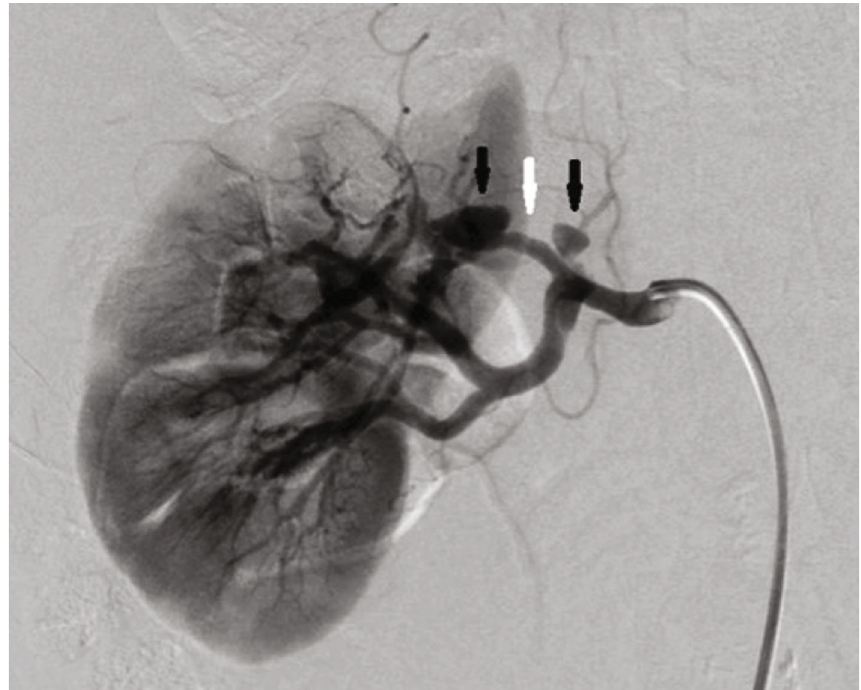
Figure 3: Aneurysms (black arrow) and narrowing (white arrow) due to dissection.